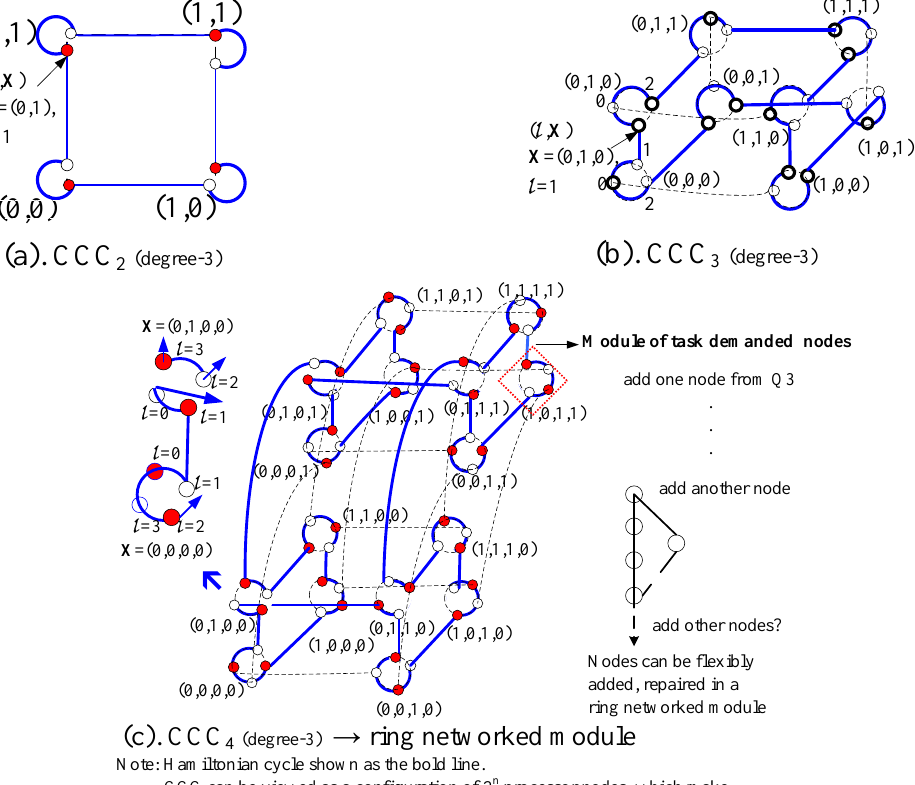
Figure 2. Relationship between Hypercubes and Cube-Connected-Cycles. ( a ) CCC CCC ; ( c ) CCC and ring networked 3 4